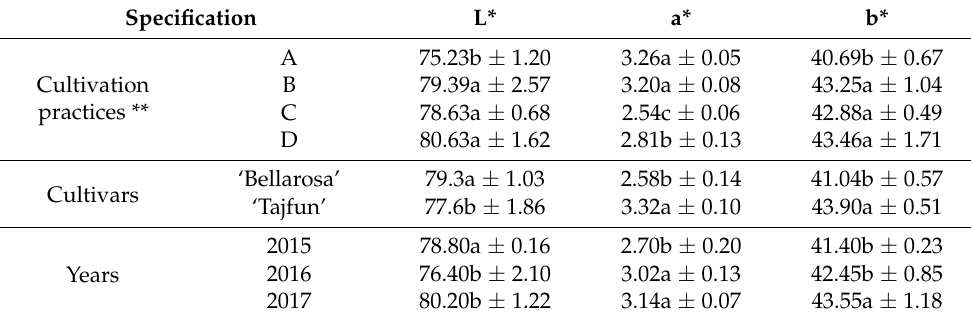
Parameter L*—brightness, parameter a*—green to red color, parameter b*—blue to yellow color, ** Cultivation practices: A—3 applications of fungicide, B—3 applications, C—5 applications, and D—8 applications of effective organisms (EmFarmaTM plus